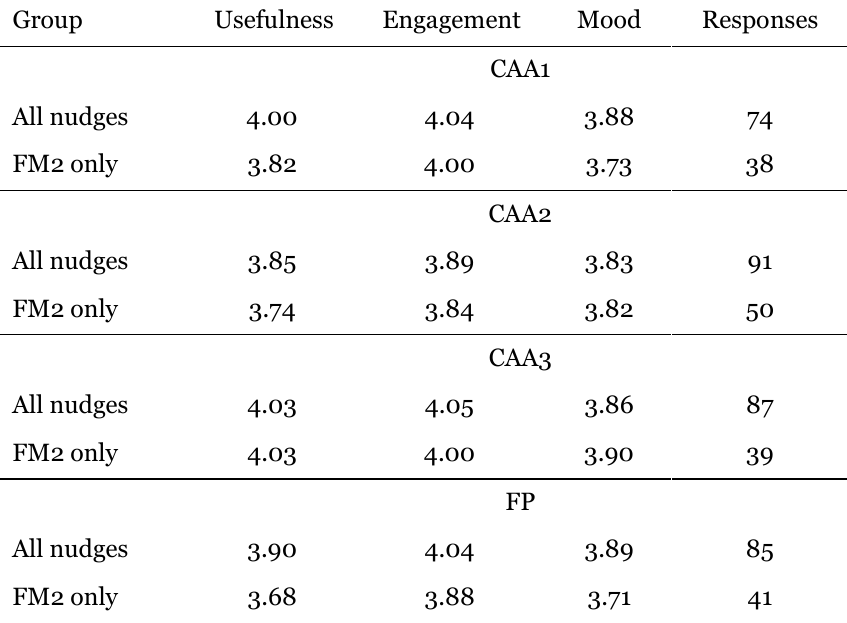
Learners’ Opinion About the Nudges: Usefulness, Engagement, and Their Mood Group Usefulness Engagement Mood Responses